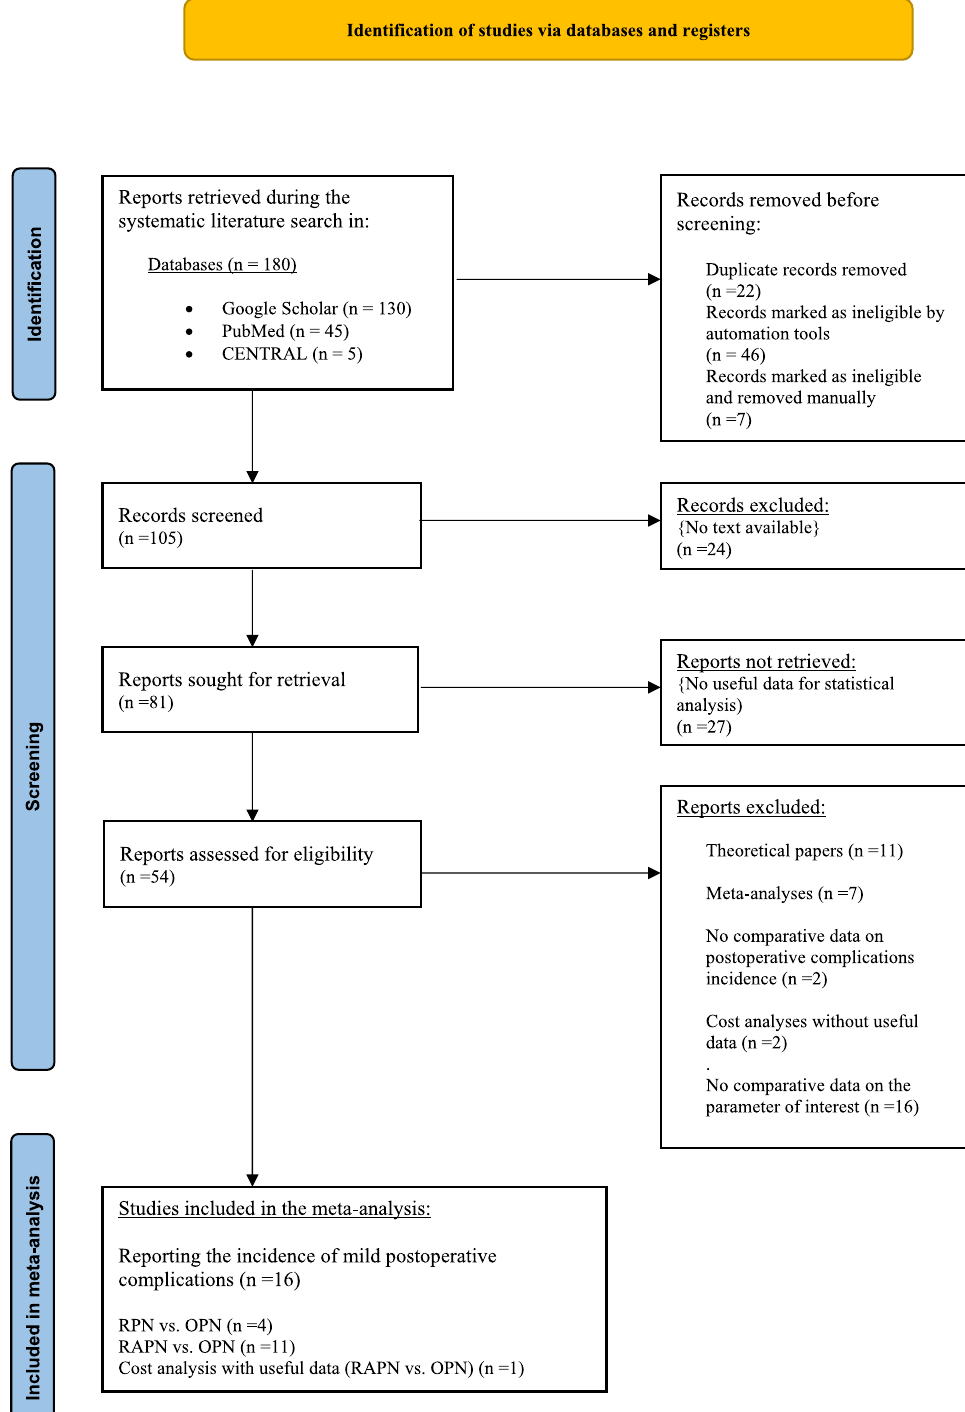
Fig. 1 Flowchart of studies according to the preferred reporting items for systematic reviews and meta-analyses